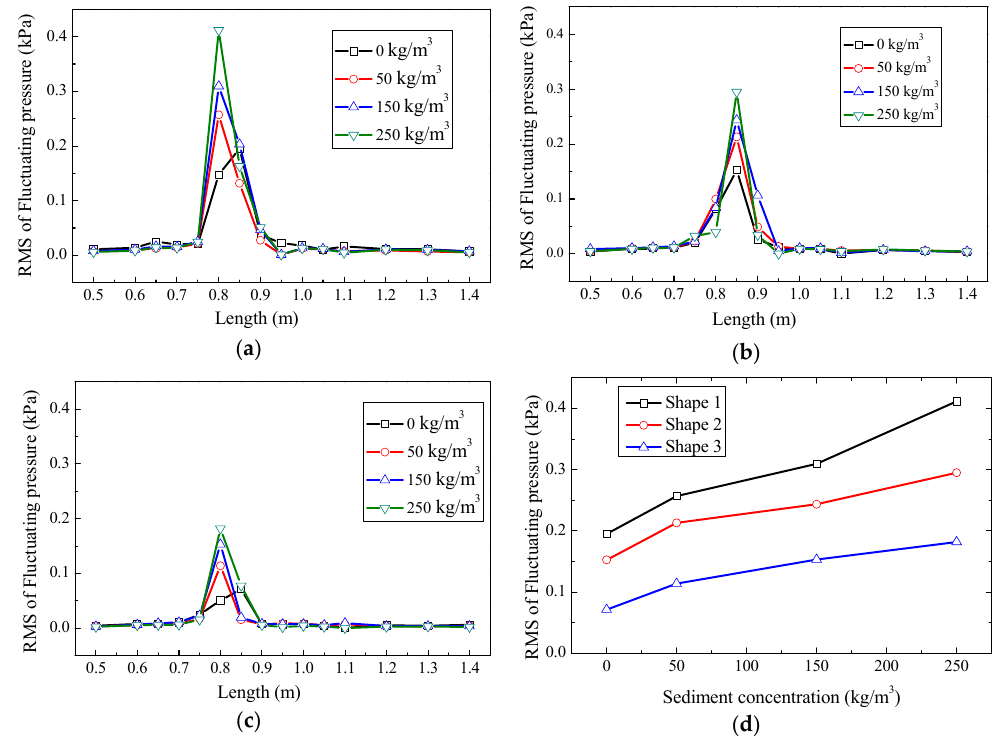
Figure 10. Distribution of fluctuating pressure at three shapes for different concentrations at upstream water head of 2.20 m and downstream water head of 0.15 m; ( a ) shape 1; ( b ) shape 2; ( c ) shape 3; ( d ) fluctuating pressure of impact point.